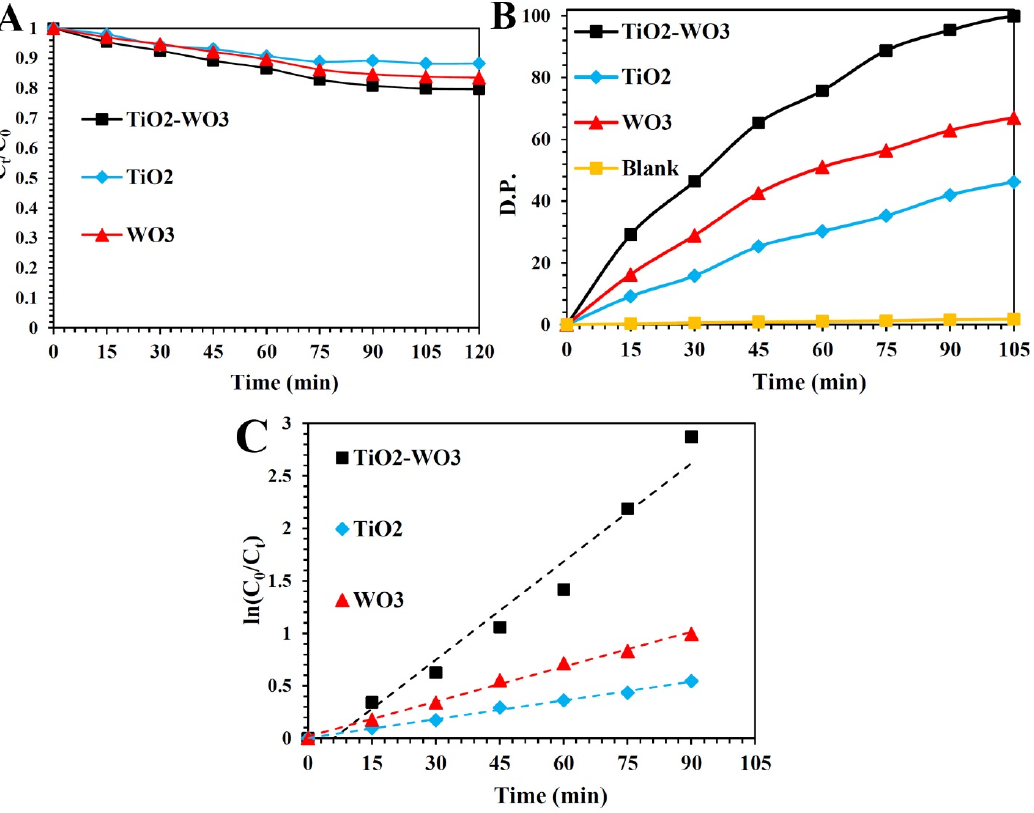
Fig. 6. (A) Change of the Nitenpyram relative concentration ( t C C ) as function of time during the adsorption process in dark condition, 0 (B) Photocatalytic degradation percentage (D.P.) of Nitenpyram insecticide over the prepared samples under visible light irradiation and (C) Pseudo first-order reaction kinetics for Nitenpyram degradation over the prepared photocatalysts